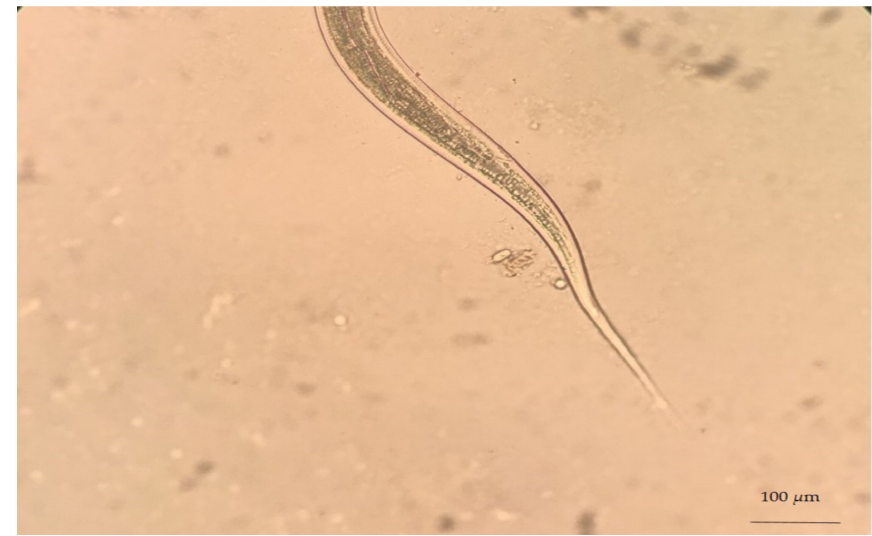
Figure 4. Haemonchus L 3 (infective stage), as seen during microscopic